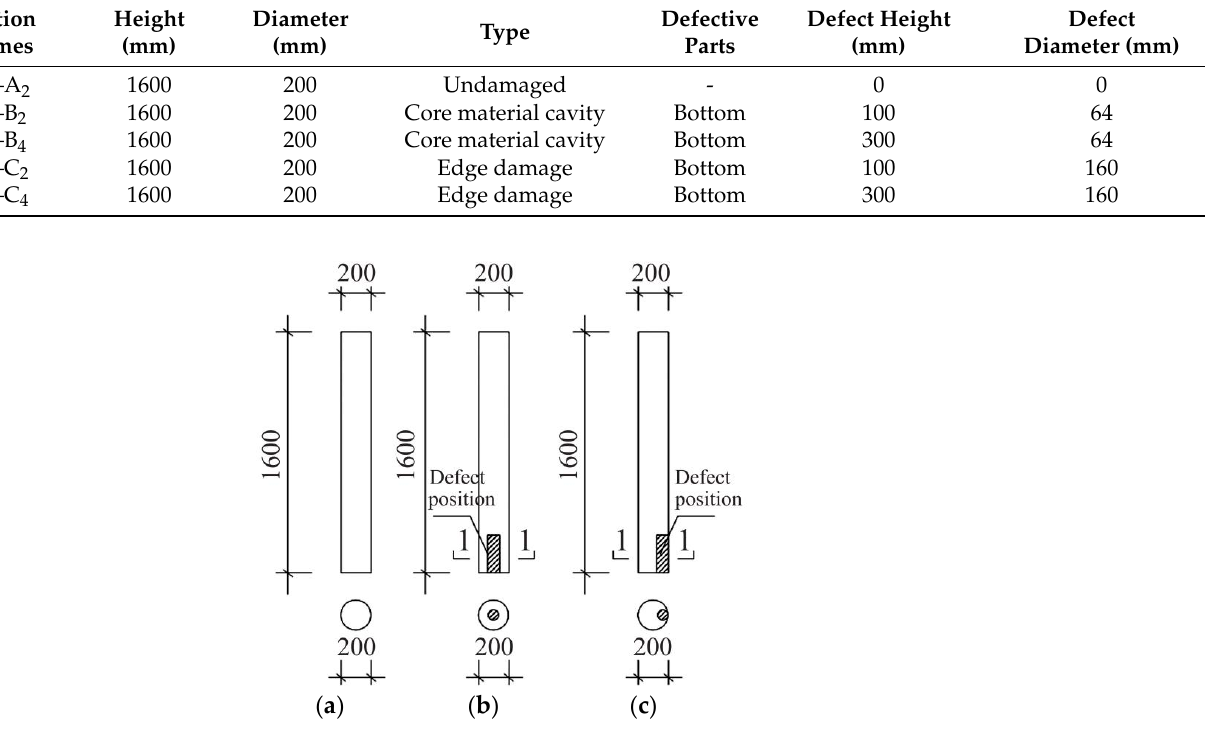
Figure 8. Size and position of damage to scaled specimens: ( a ) Undamaged; ( b ) Core material cavity; ( c ) Edge damage.